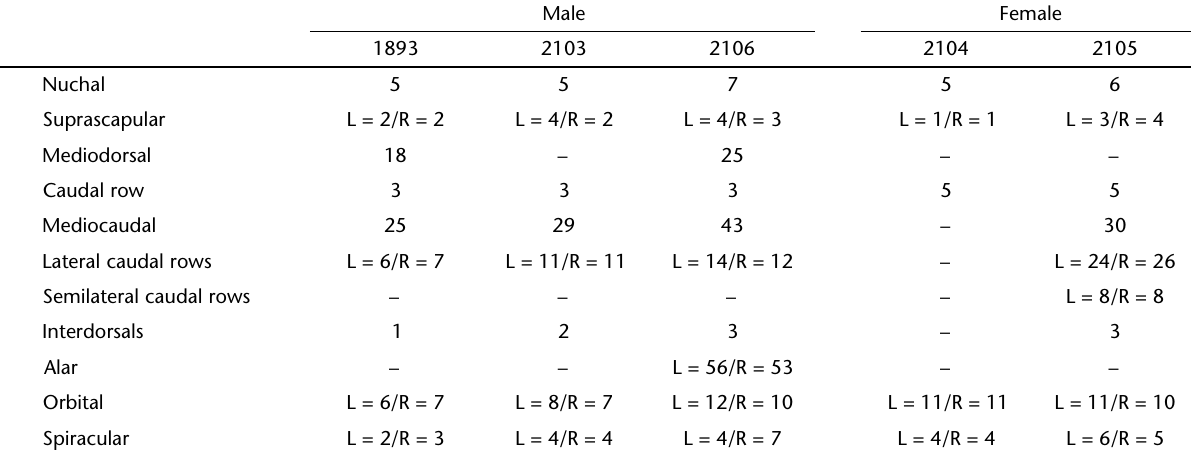
Table II. Thorn counts in specimens of D. mennii (R = right, L = left); all five specimens are from the UERJ collection.